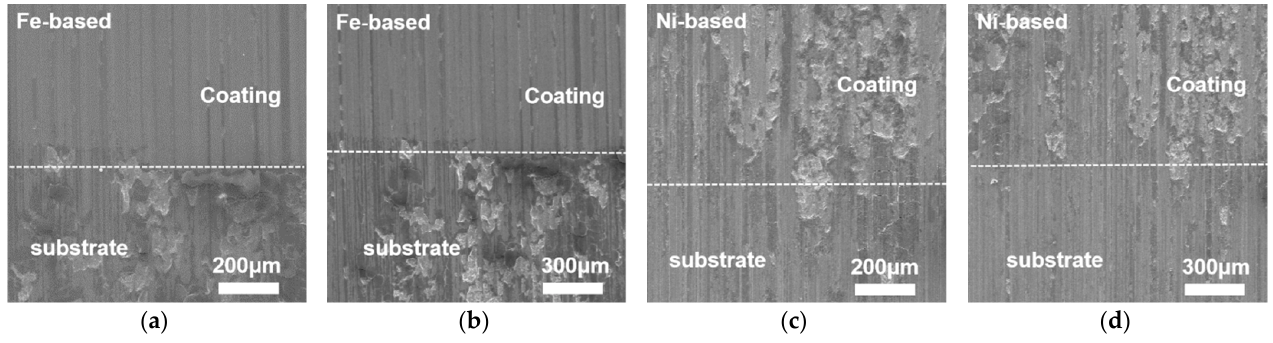
Figure 10. Two coating interface SEM images. ( a ) The interface of Fe-based at 200 μ m of the scale; ( b ) The interface of Fe-based at 300 μ m of the scale; ( c ) The interface of Ni-based at 200 μ m of the scale; ( d ) The interface of Ni-based at 300 μ m of the scale.